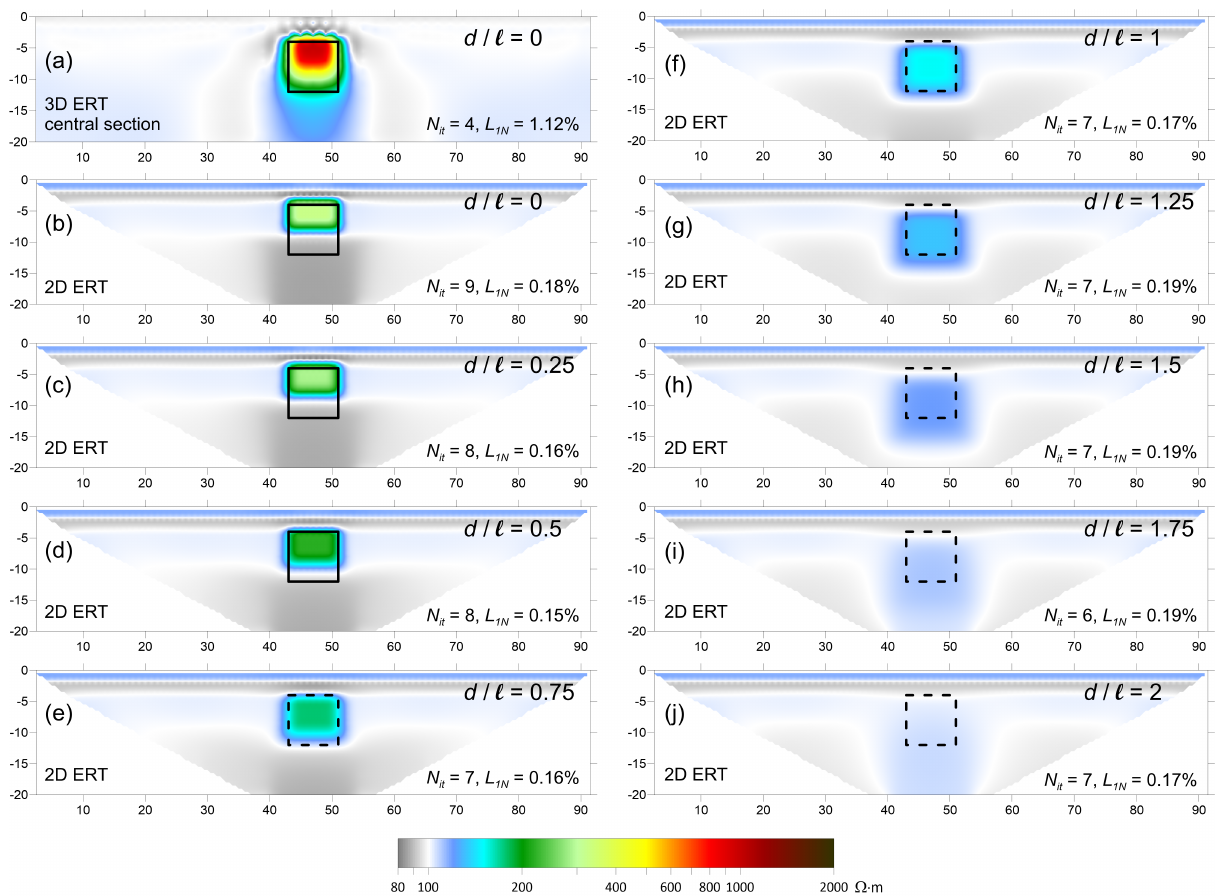
Figure 4. Inverse models obtained starting from the 3D model of cube-shaped resistive block. ( a ) Central section of the 3D ERT and ( b – j ) 2D ERT when varying the orthogonal distance d between the electrode line and the projection in the surface of the center of the cube. The solid black line indicates the boundaries of the cube when the section intersects it. The dashed black line indicates the projection of the boundaries of the cube when it is not intersected by the